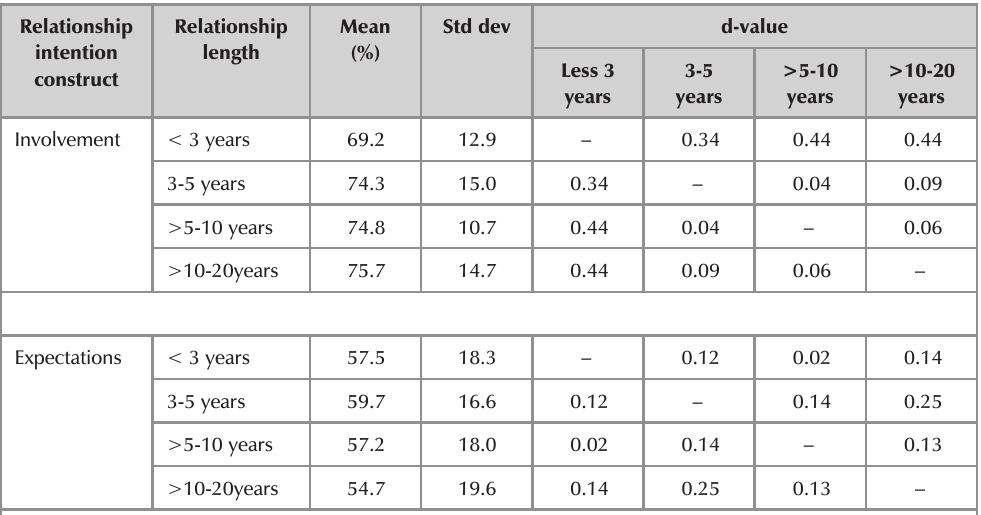
Relationship intention scores of length of client